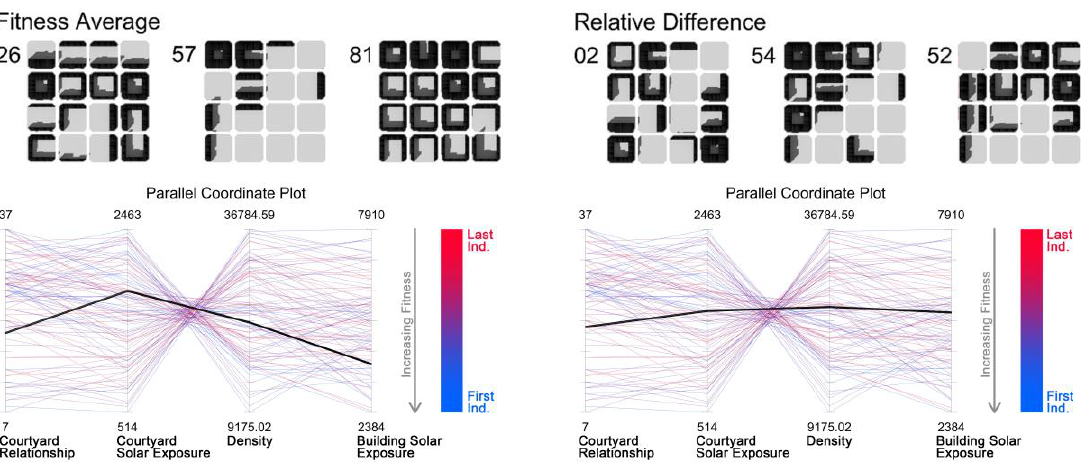
Figure 10. ( Top ) First three ranked individuals for Fitness Average (individuals num.: 26, 57, and 81) and Relative Difference (individuals num.: 02, 54, and 52). ( Below ) Parallel Coordinate Plot shows fitness relation for the first ranked individual (26 and 02). Individuals 57 and 81 show high specialization in connectivity and CY exposure, and density and B exposure, respectively.